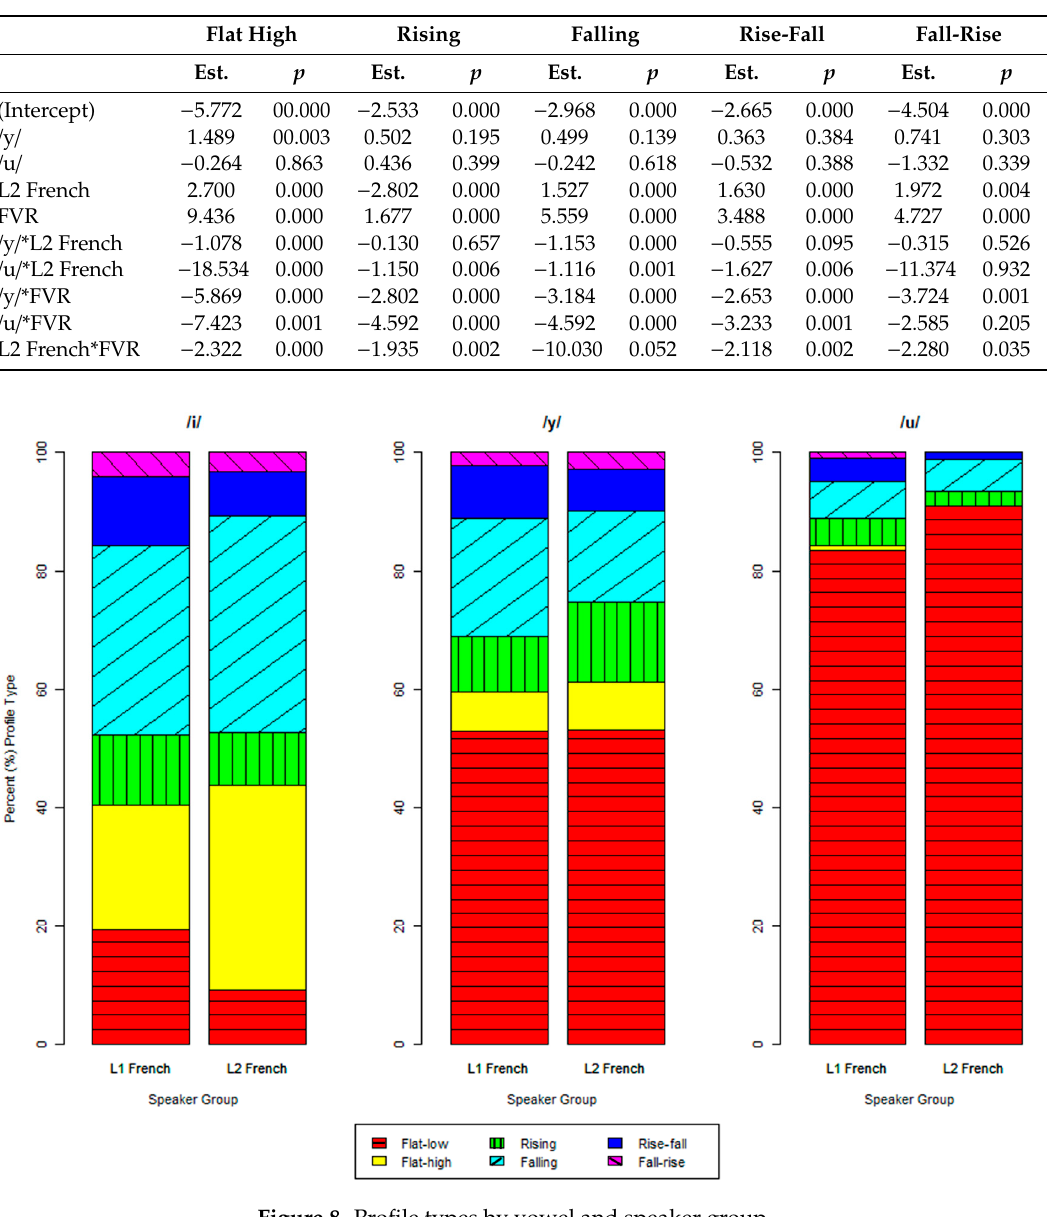
Figure 8. Profile types by vowel and speaker group.